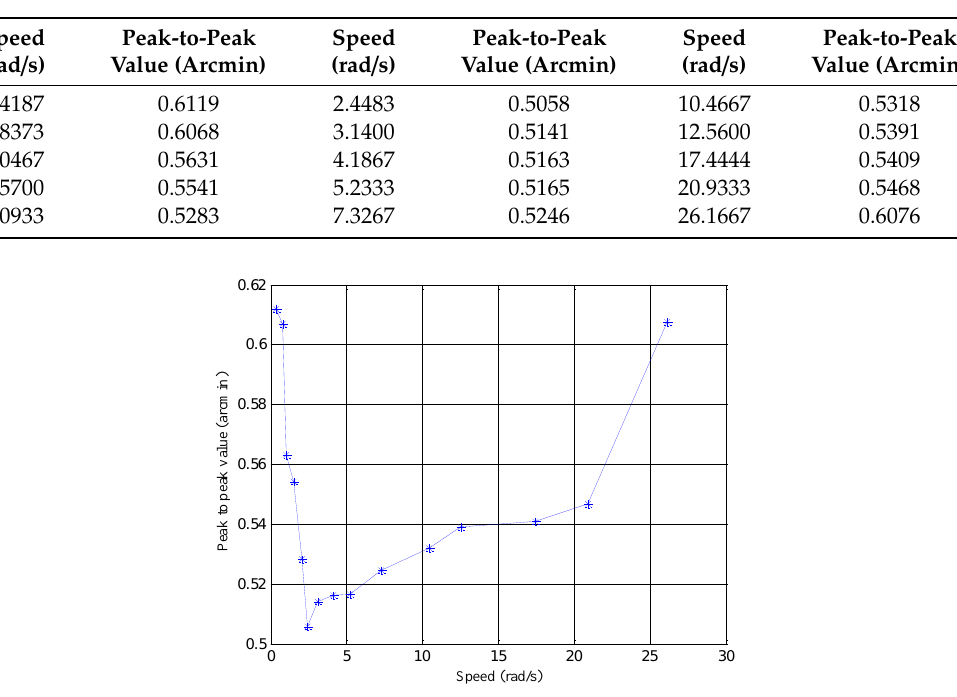
Figure 7. Transmission error curve (2.4483 rad/s). Table 3. Peak-to-peak values of transmission errors under di ff erent speeds.